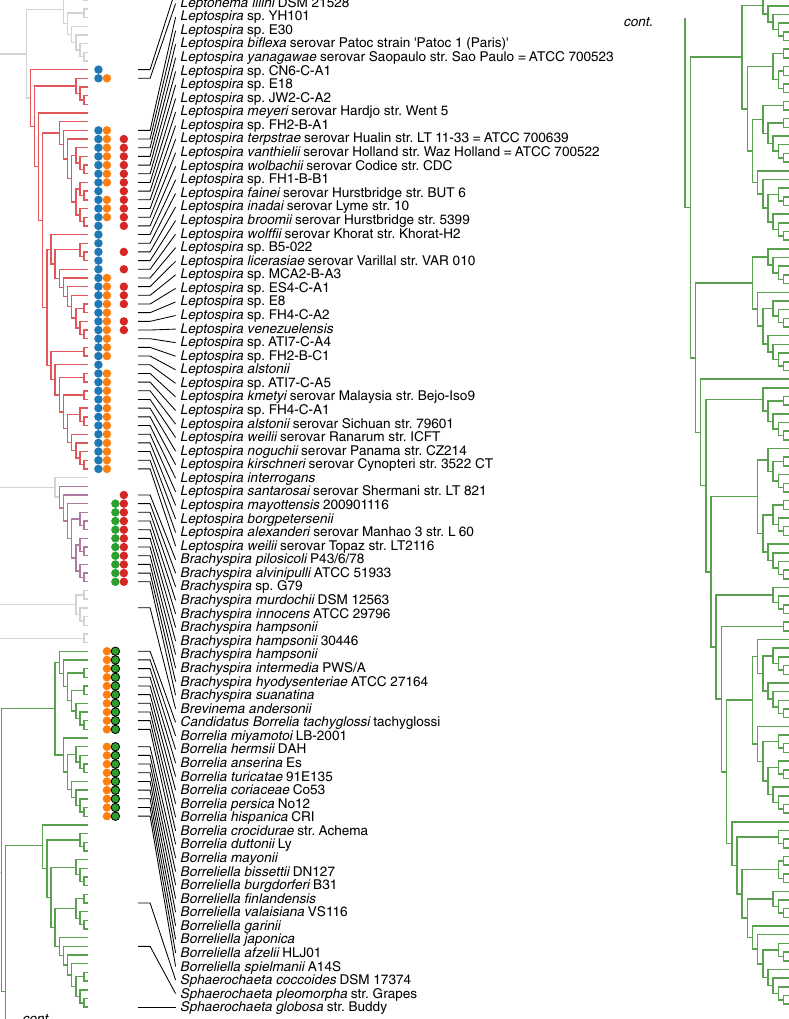
Fig. 2 The pro fi le of most common chemosensory classes in Spirochaetota. The three major taxonomy classes are colored: Leptospirae (red), Brachyspirae (purple), and Spirochaetia (green). Species found in MiST3 are represented by their species and strain name. The pro fi le shows the presence of the common chemotaxis classes F1(blue), F8(orange), F2 (green), and F7(red). The systems with CheW-CheR like (F2 systems) are marked with a black outline. An additional high-resolution fi gure is separately